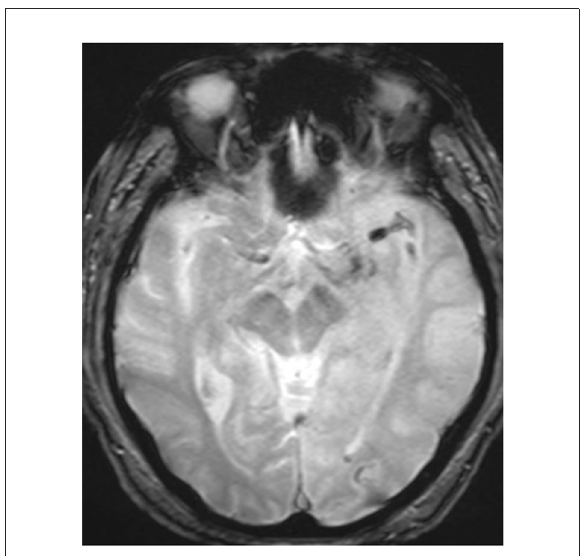
FIGURE1 Initial hemoflash image demonstrating a thrombus in the left M1 branch of the left MCA prior to